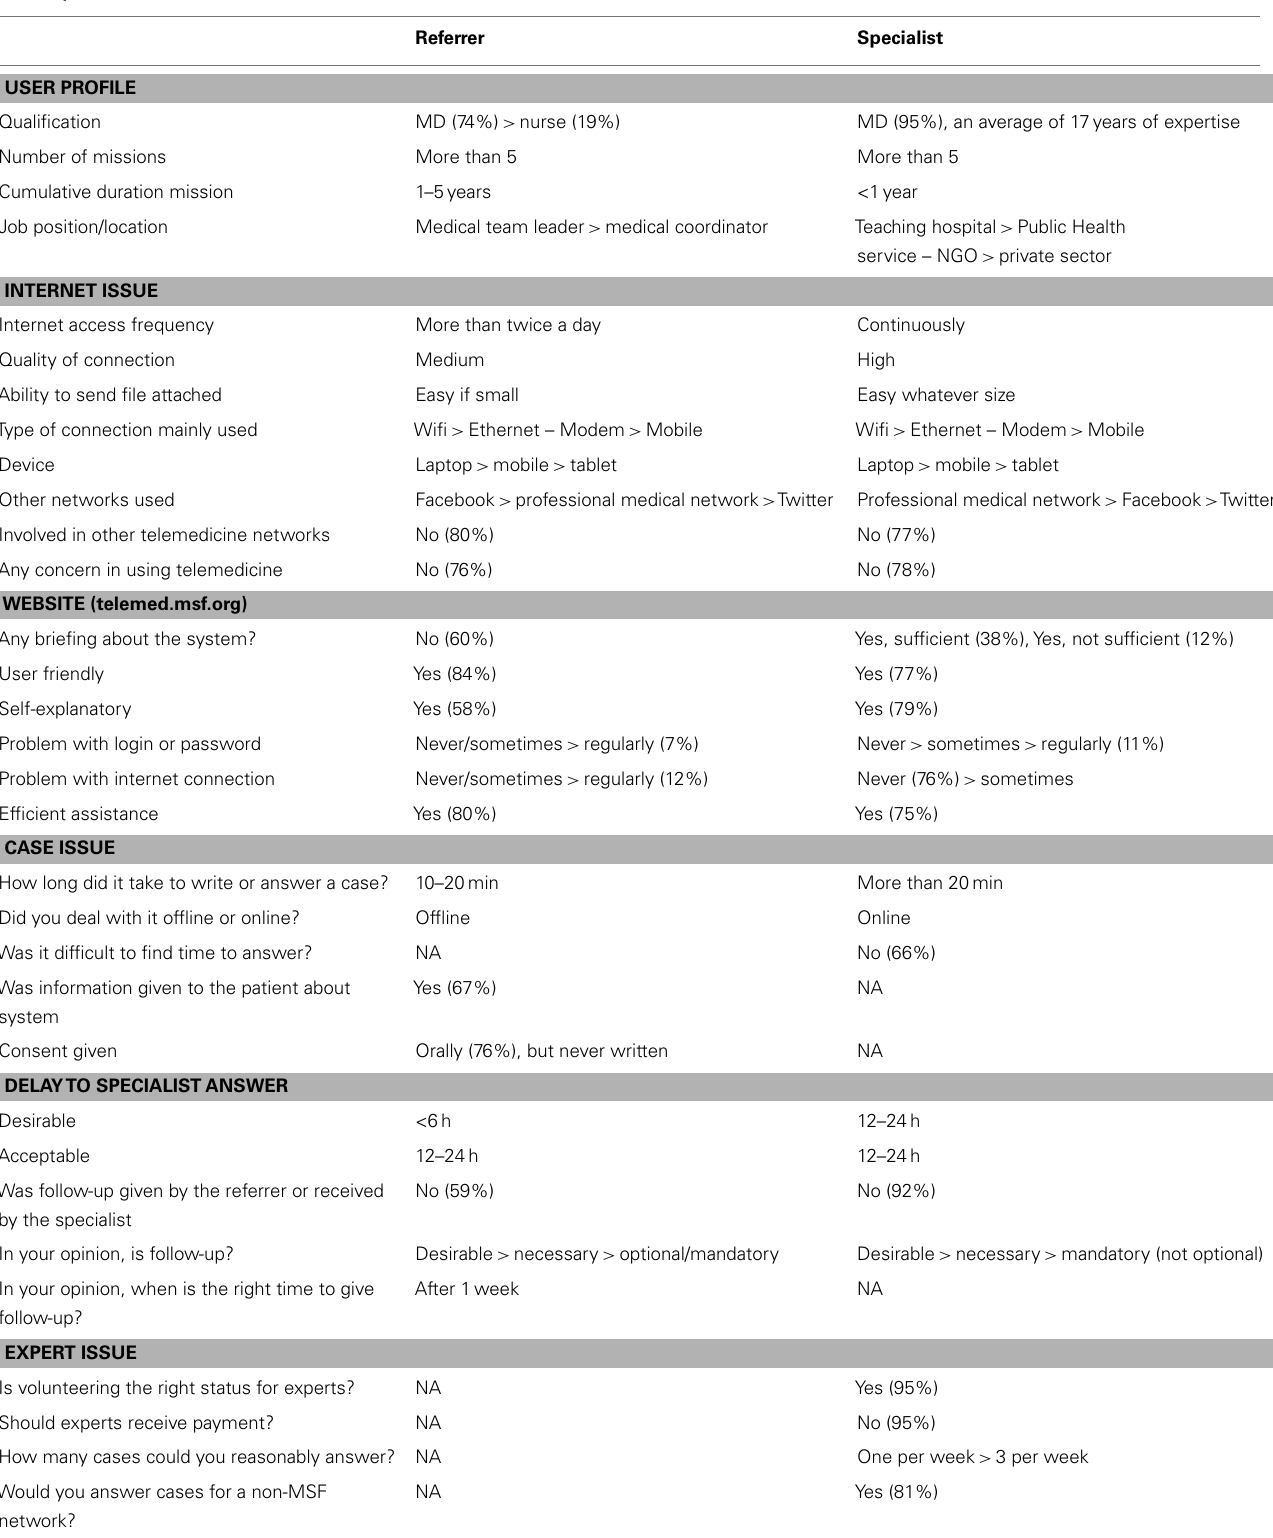
Table 3 | Main features of the user profile